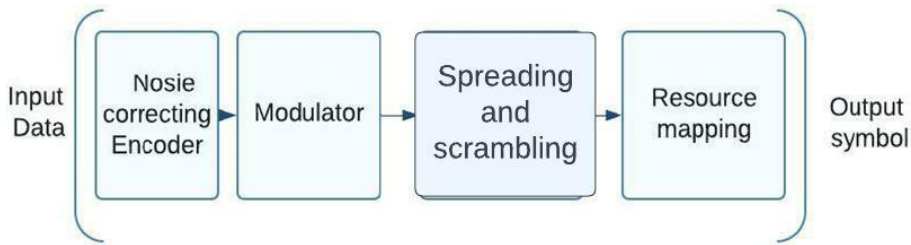
Figure 7. Design of a NOMA system ’ s character-level hybrid processing.